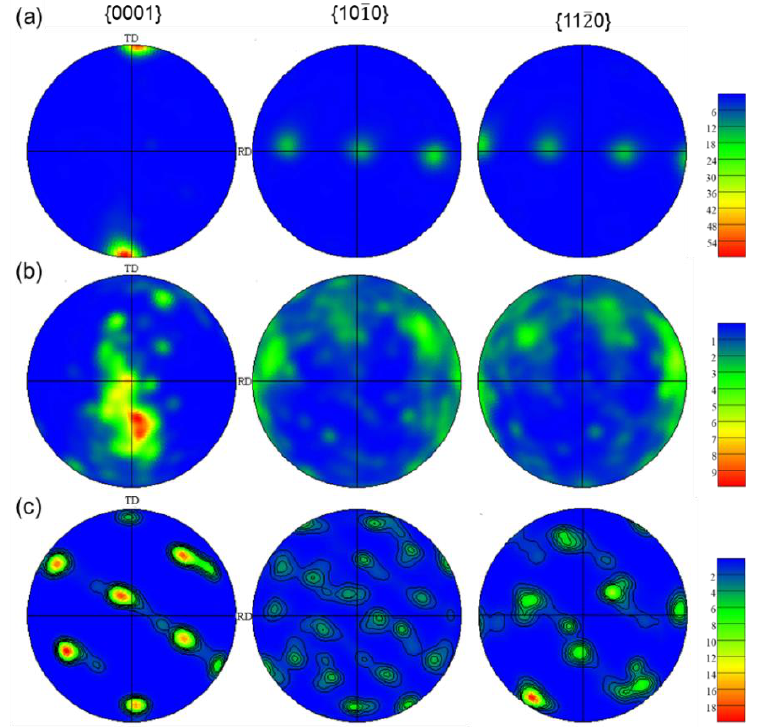
Figure 9. SEM-EBSD pole figures of Ti-6Al-V alloy deformed by 90% at different temperatures: ( a ) 850 °C, ( b ) 950 °C, ( c ) 1100 °C.